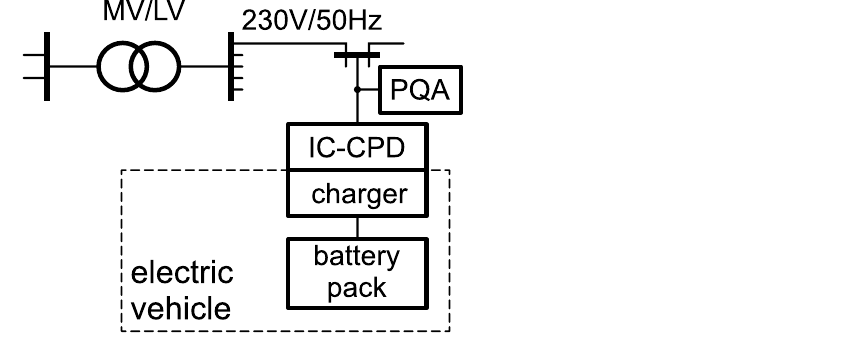
Figure 1. The diagram of the battery pack charging circuit with the measurement point marked, where MV/LV is the medium-voltage to low-voltage transformer, PQA is the power quality analyzer, IC–CPD is the in-cable control and protection device, and the charger is the battery pack charging process control system.